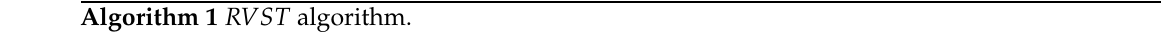
Algorithm 1 RVST algorithm.